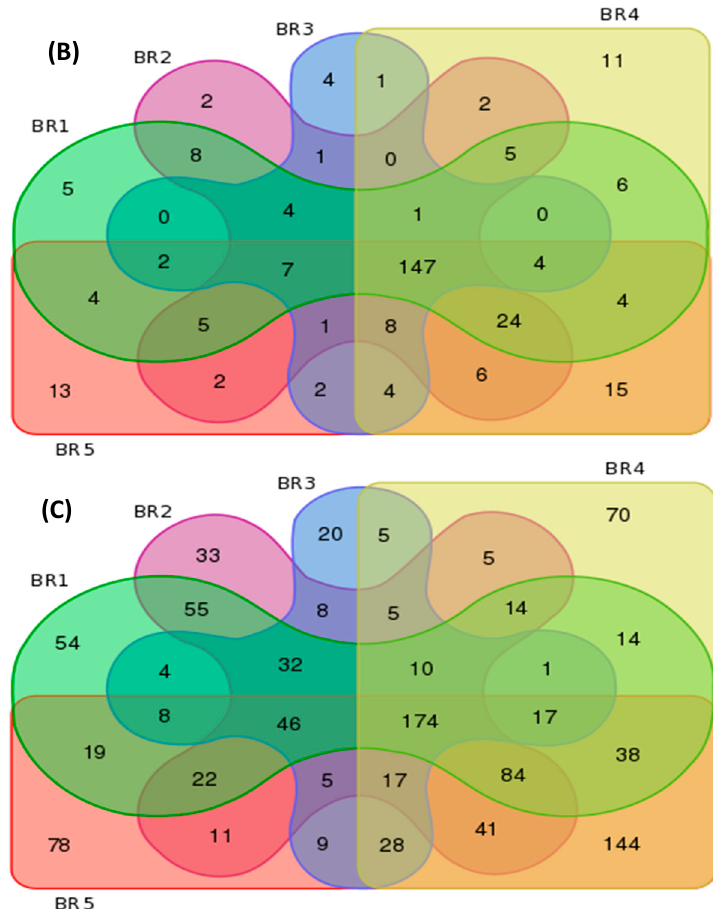
Figure 3. Bacterial metagenomics similarity and uniqueness characterization based on ( A ) order; ( B ) family and ( C ) genus.